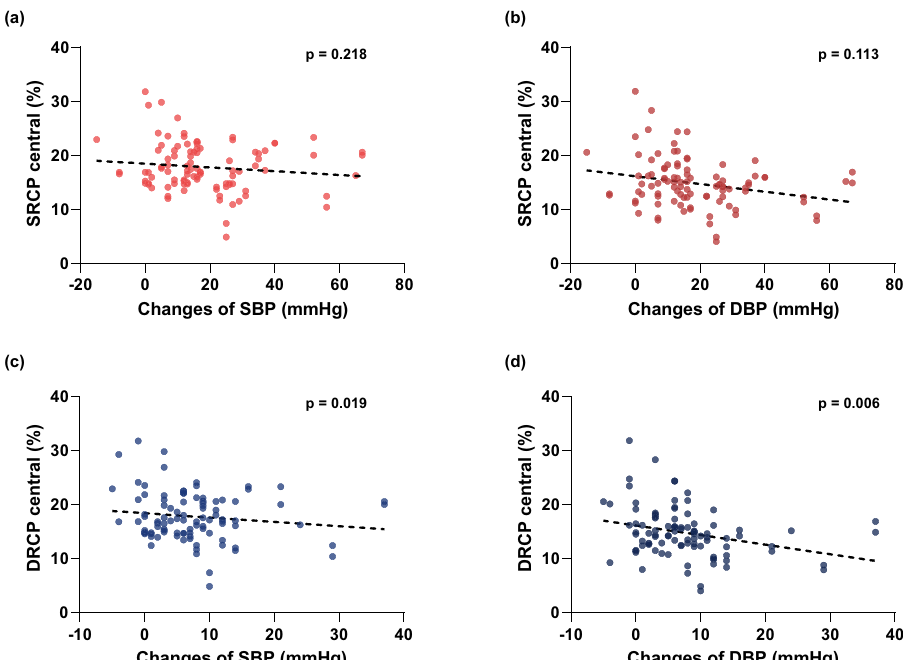
Fig. 2 Correlations between the OCTA parameters and changes in blood pressure. The super fi cial retinal capillary plexus (DRCP) vessel density in the central region did not have a signi fi cant relationship with the changes in systolic blood pressure (SBP) and diastolic blood pressure (DBP) ( a , b ). The deep retinal capillary plexus (DRCP) vessel density in the central region had a negative correlation with changes in SBP and DBP ( c , d ).